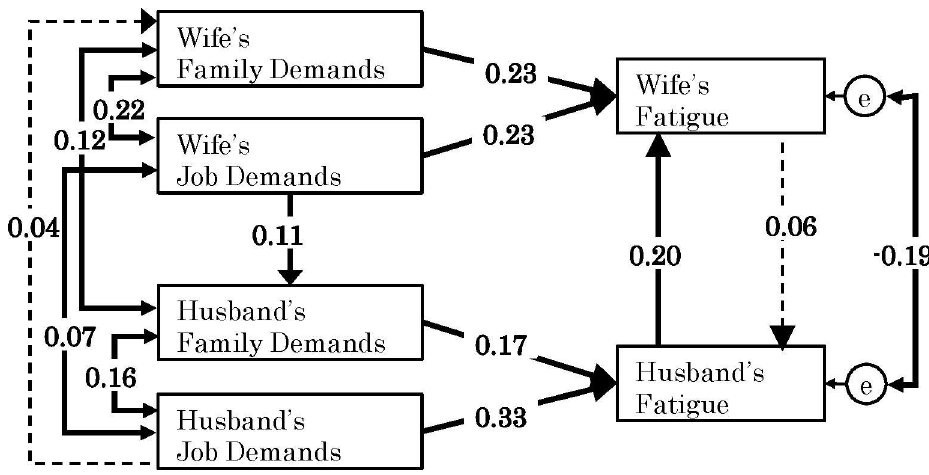
Fig 2. A crossovermodel of associations between job and family demands and fatigue. Estimates representstandardizedcoefficients. Significant paths (p < 0.05) are shown with solid lines. Non-significant paths are shown with dotted